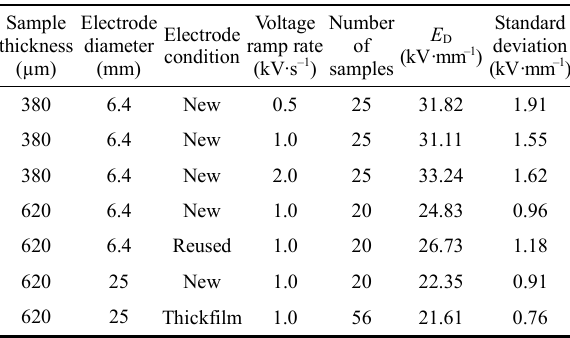
Table 1 Summary of all short time test conditions and results Sample